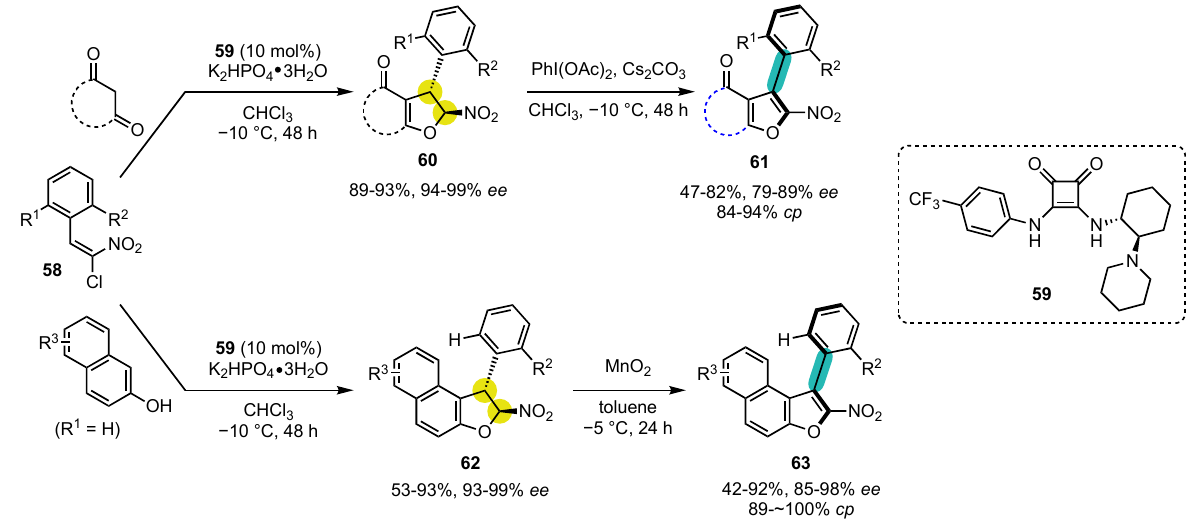
Scheme 17. Enantioselective synthesis of atropisomeric 3 ‐ arylfurans.